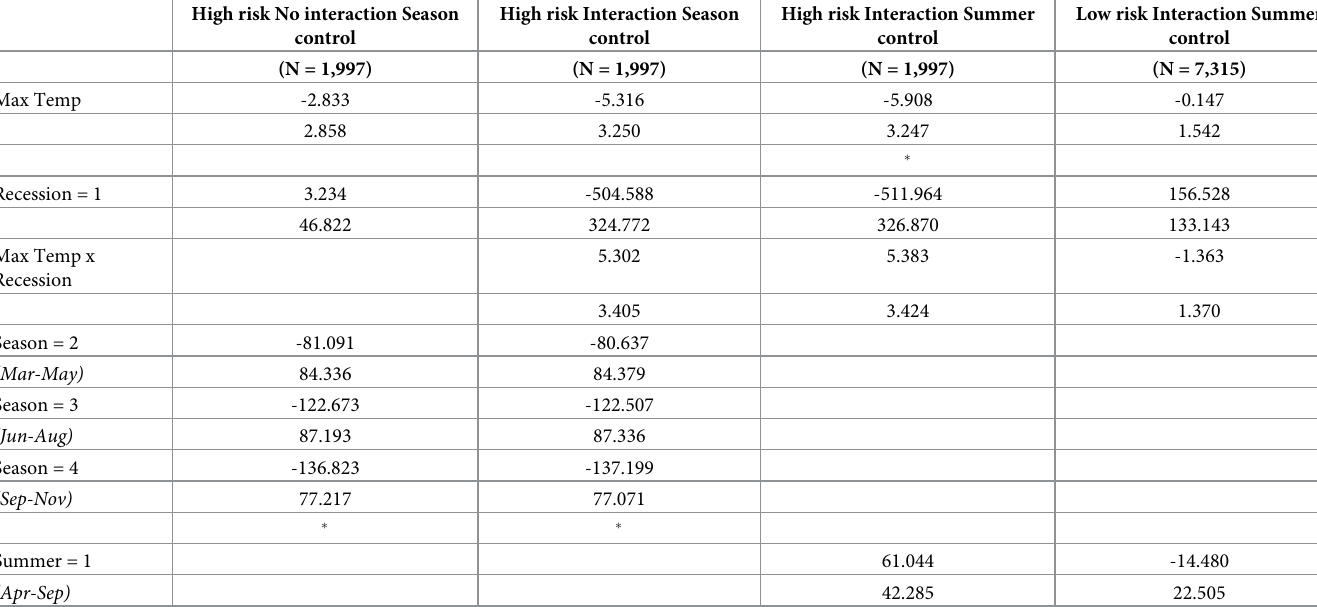
Table 3. Linear regression results restricted to days over 90 degrees.